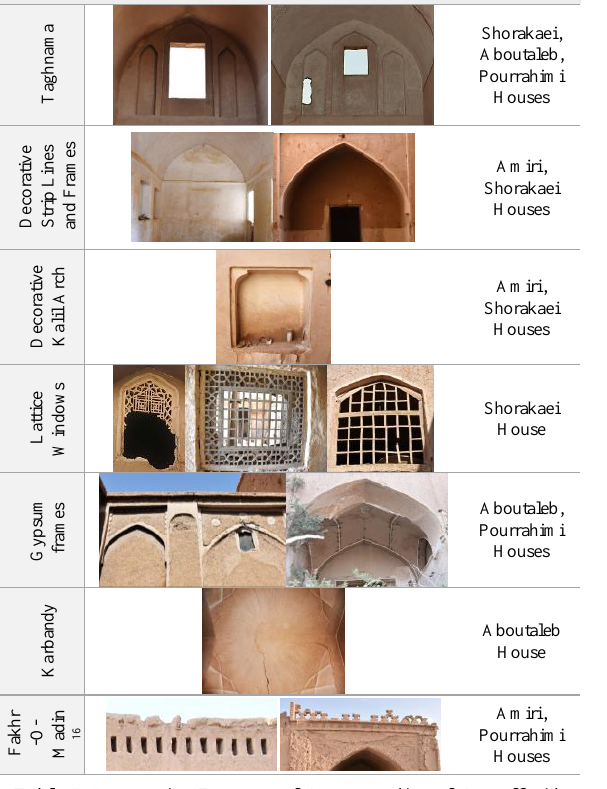
Table 5. Decorative Features of 4 case studies of Muzaffarid Houses. Reference: